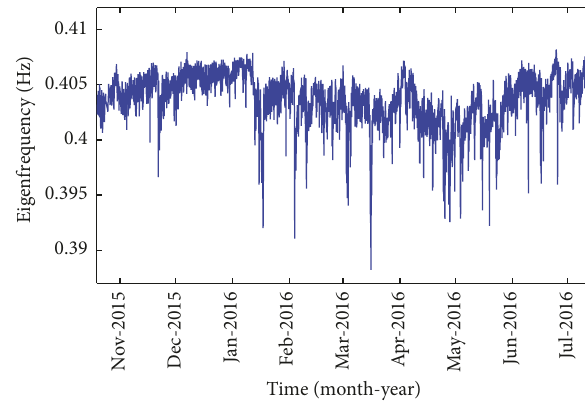
Figure 7: Time trend of the first eigenfrequency. Figure 8: Time trend of the second